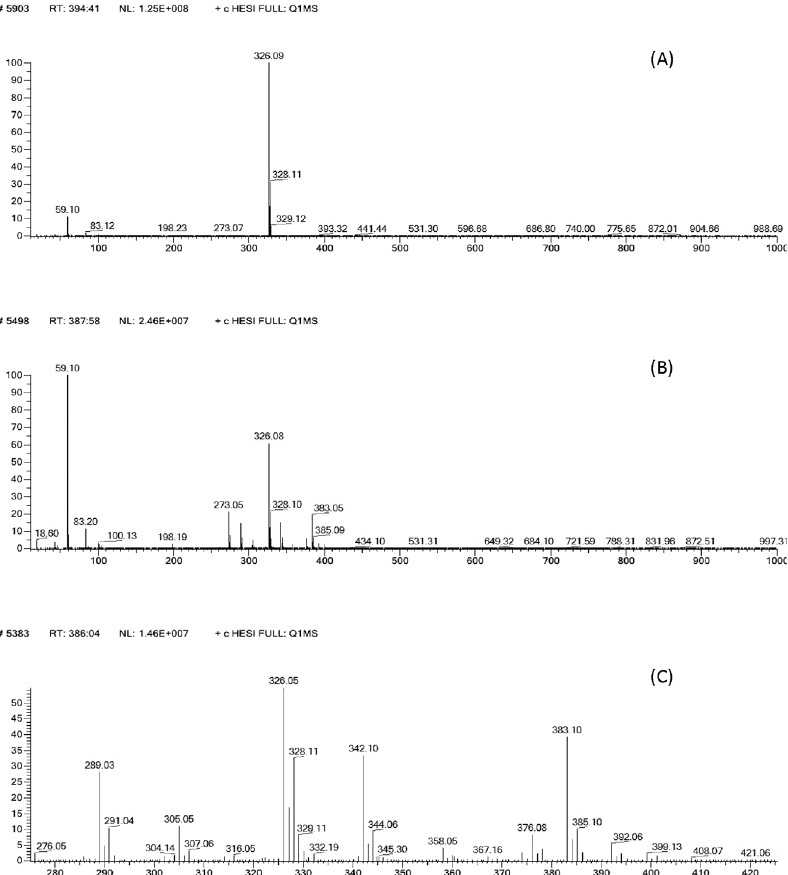
Figure 3: Positive ion mass spectrum of midazolam hydrochloride reference solutionat10µg/mL(asfreebase)obtained in full scan mode (0 – 1000 m / z range) without degradation (A) and after exposure to H 2 O 2 30% for 3 h (0 – 1000 m / z range (B) and 275 – 425 m / z range